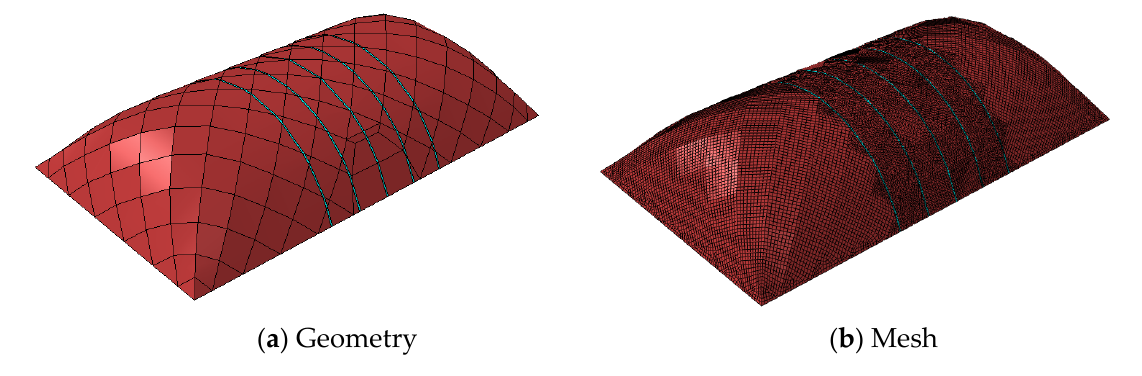
Figure 9. The FE models.